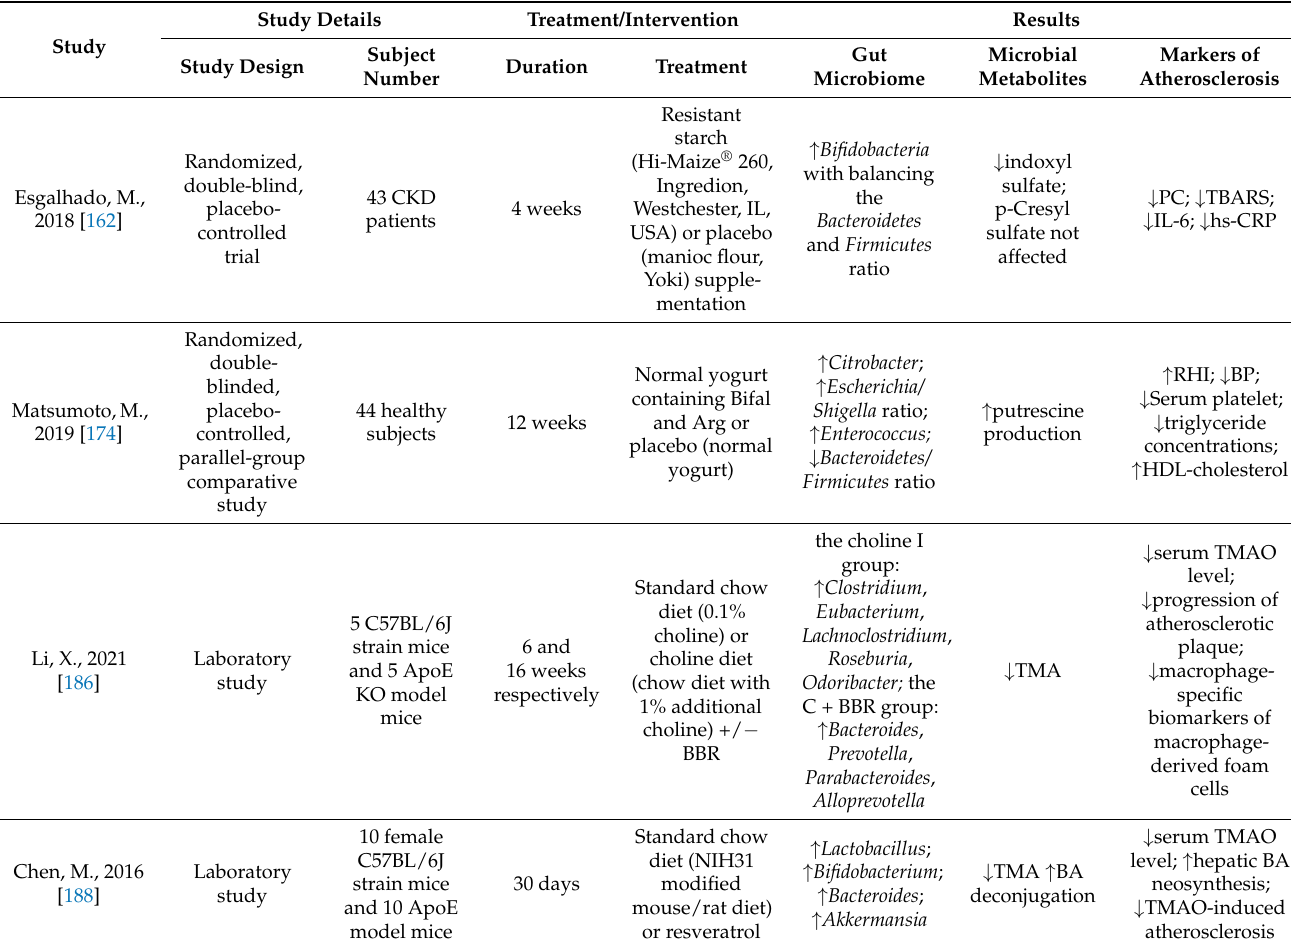
Table 3. Summary of recent studies linking gut microbiome, dietary interventions, and